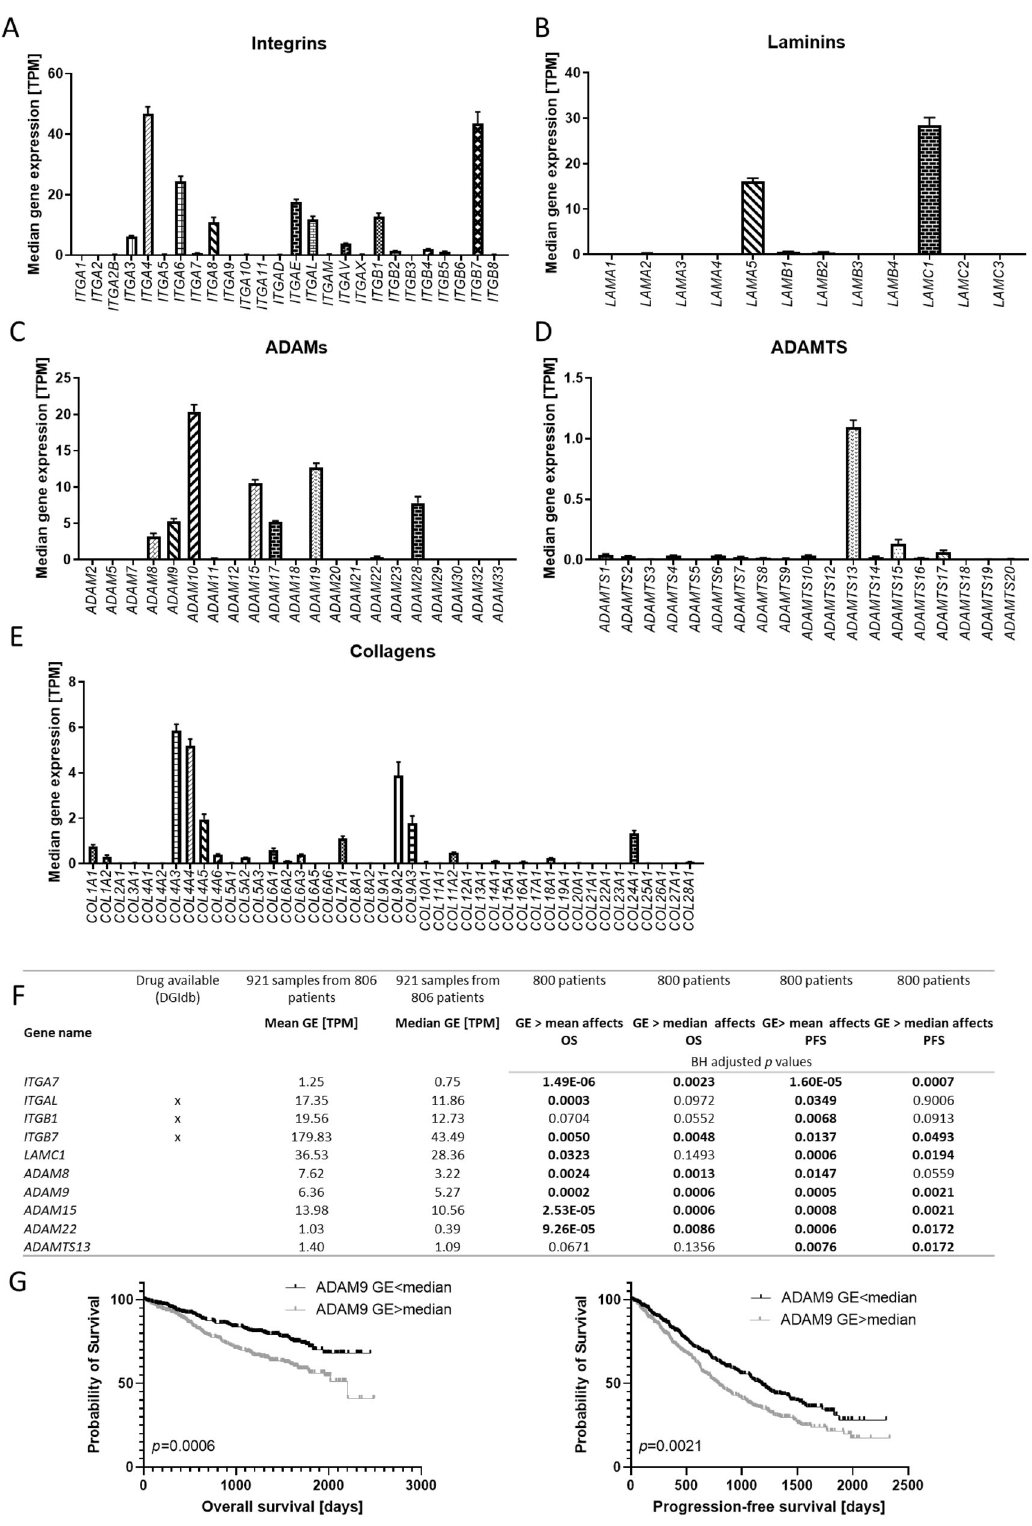
Fig. 2 ECM gene expression levels as prognostic markers in MM. Gene expression of integrin ( A ), laminin ( B ), ADAM ( C ), ADAMTS ( D ) and collagen ( E ) genes determined by RNA sequencing of 921 samples from 806 patients of the MMRF cohort. Data shown is median transcripts per kilobase million (TPM) with 95% CI. F Summary of selected genes where a GE higher than the mean or median is signi fi cantly associated with PFS and/or OS. Comparisons were performed using the Kaplan Meier method and Log Rank test. P values were adjusted for multiple hypotheses using the Benjamini-Hochberg (BH) correction in R. For Kaplan Meier plots see Fig. S2. DGIdb was used to reveal druggable targets. G Exemplary Kaplan Meier plots comparing PFS and OS of patients with a high (>median) or low (<median) ADAM9 GE. Statistical test was Log Rank test. Graphs were created using GraphPad Prism